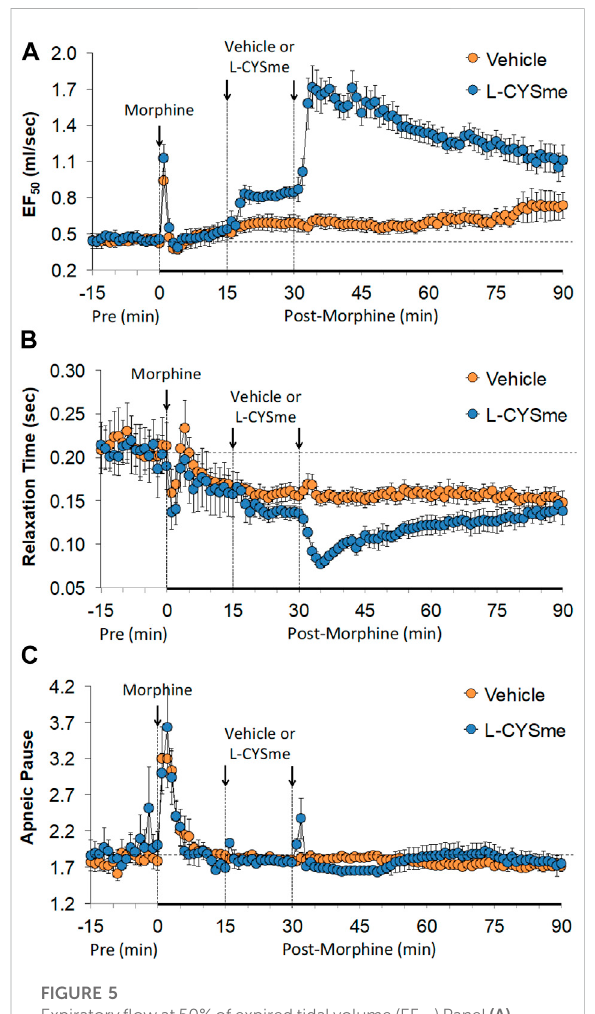
FIGURE 5 Expiratory fl owat50%ofexpiredtidalvolume(EF 50 )Panel (A) , relaxation time Panel (B) and apneic pause Panel (C) prior to (Pre), following the injection of morphine (10 mg/kg, IV), and then two injections of vehicle or L-cysteine methyl ester (L-CYSme, 500 μ mol/kg, IV) given 15 min apart, in freely-moving rats. The data are presented as mean ± SEM. There were 6 rats in each group.